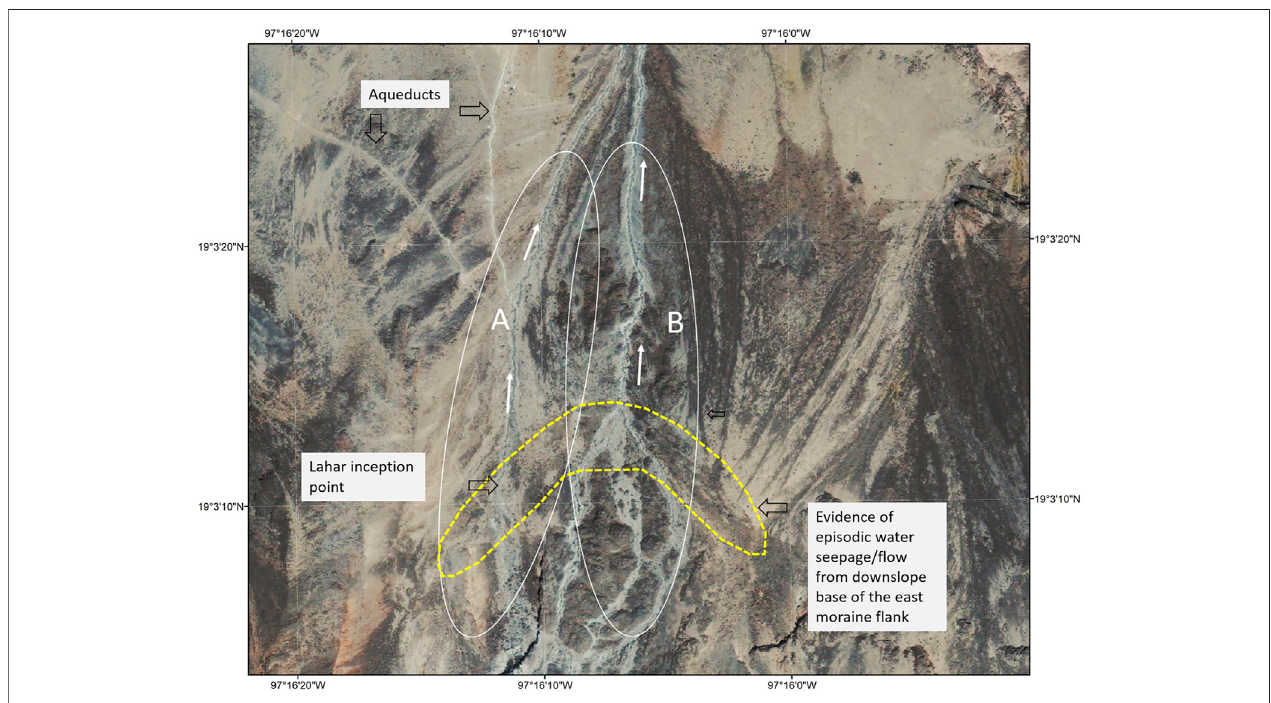
FIGURE 5 | Annotated scene of the LIA terminal zone of the glacier, discriminating two distinct surface hydrology zones. Ellipse (A) identi fi es a surface drainage system from the west side lateral moraine and erosional deposits. Ellipse (B) identi fi es a surface drainage system from the lava fl ow.